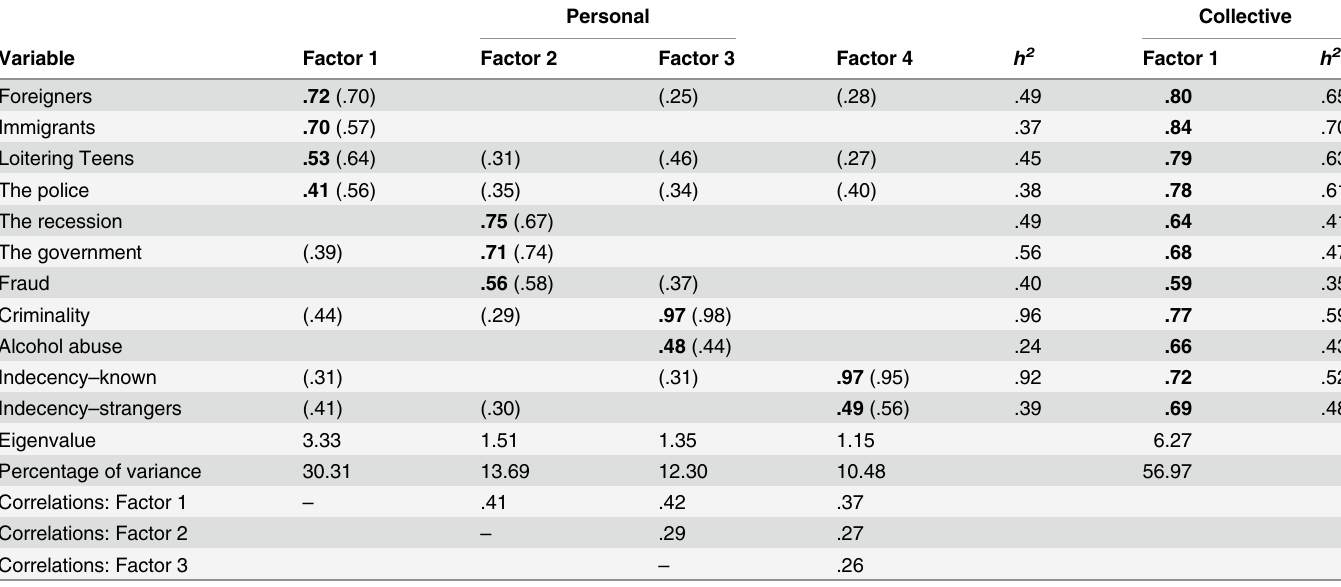
Table 1. EFA Pattern and Structure Coefficients of Prevalence Estimates (Promax; Study